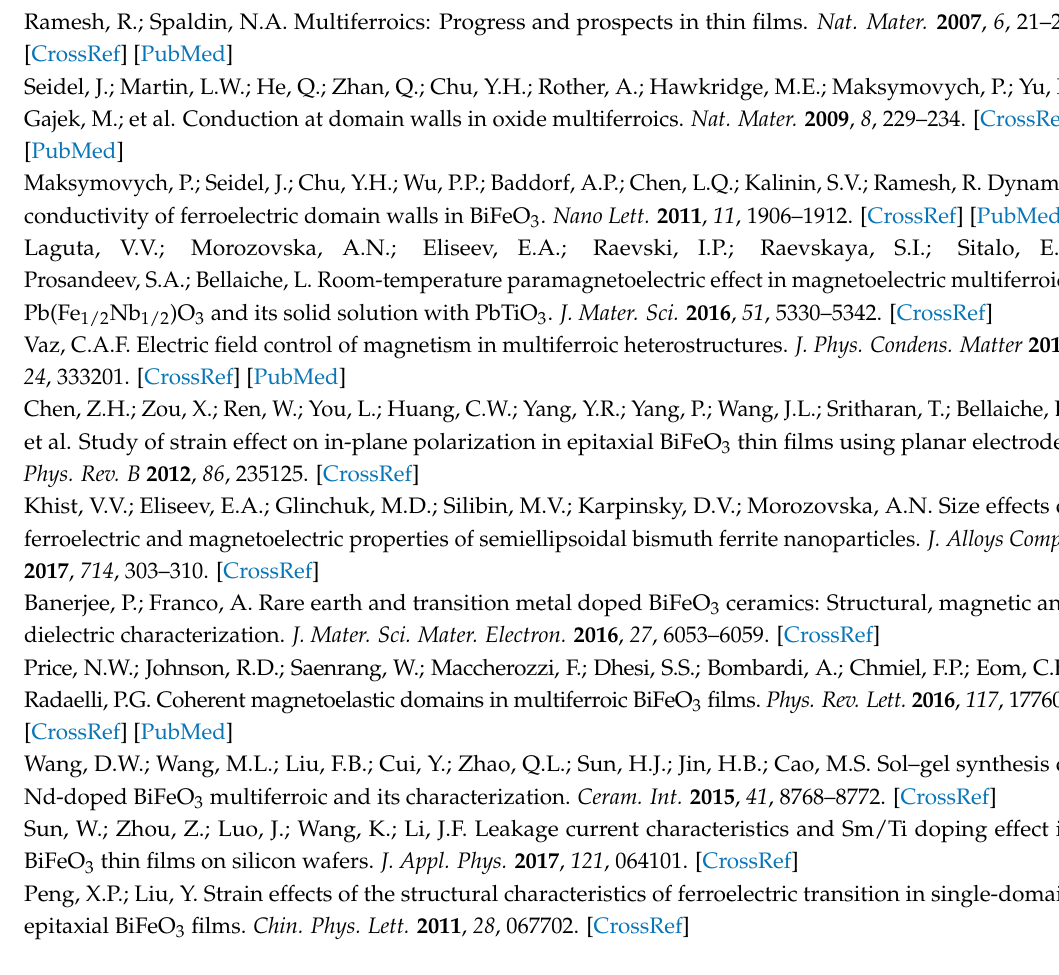
Figure S1: The topography image (a,d) of BFMO films with the deposition oxygen pressures of 2 Pa and 10 Pa respectively, the corresponding out-of-plane PFM images (b,e) and the in-plane images (c,f),Figure S2: The I–V curves (c,f) of BFMO films deposited at a P O of 2 Pa. The insert shows the position of points A, B, C and D, Figure 2 S3: The topography image (a) of BFMO film with the deposition oxygen pressure of 2 Pa. The corresponding in-plane piezoresponse phase image (b–h) after being depolarized with +11 V voltage with the tip earthed for different periods of time, Table S1: The average size of all backswitched domains in the poled area in Figure